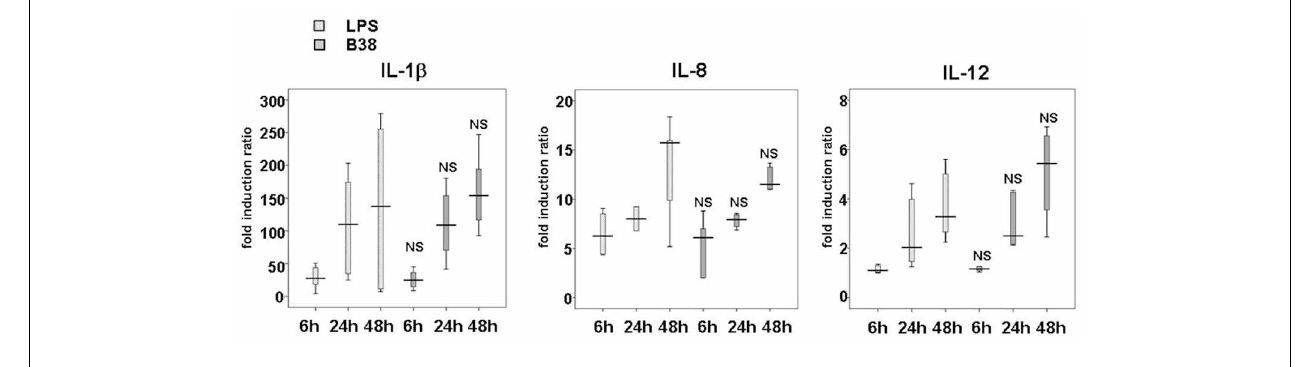
FIGURE A4 | Kinetics of IL-1 β , IL-8 and IL-12 production by E. coli LPS- or H. pylori -activated dendritic cells. DCs were either stimulated with E. coli LPS (100ng/mL) or cocultivated with H. pylori B38 strain at MOI 1 for 6, 24, or 48h. IL-1 β , IL-8, and IL-12 secretion levels were assessed by ELISA (as described in Material and Methods). The horizontal bar across the box indicates the median and